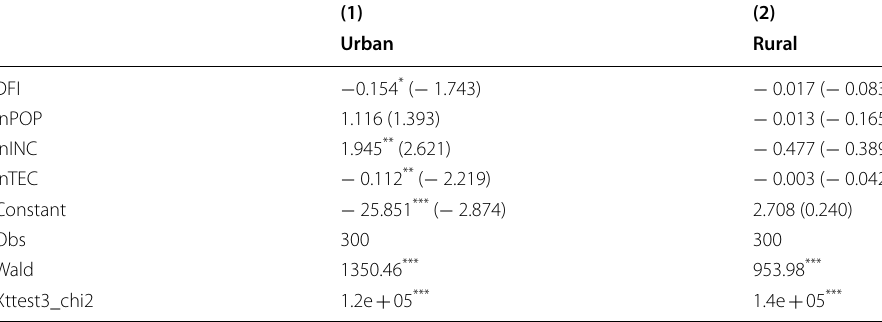
The values in parentheses represent the t-statistics * , ** , *** imply the significance at the 10%, 5%, and 1% levels,